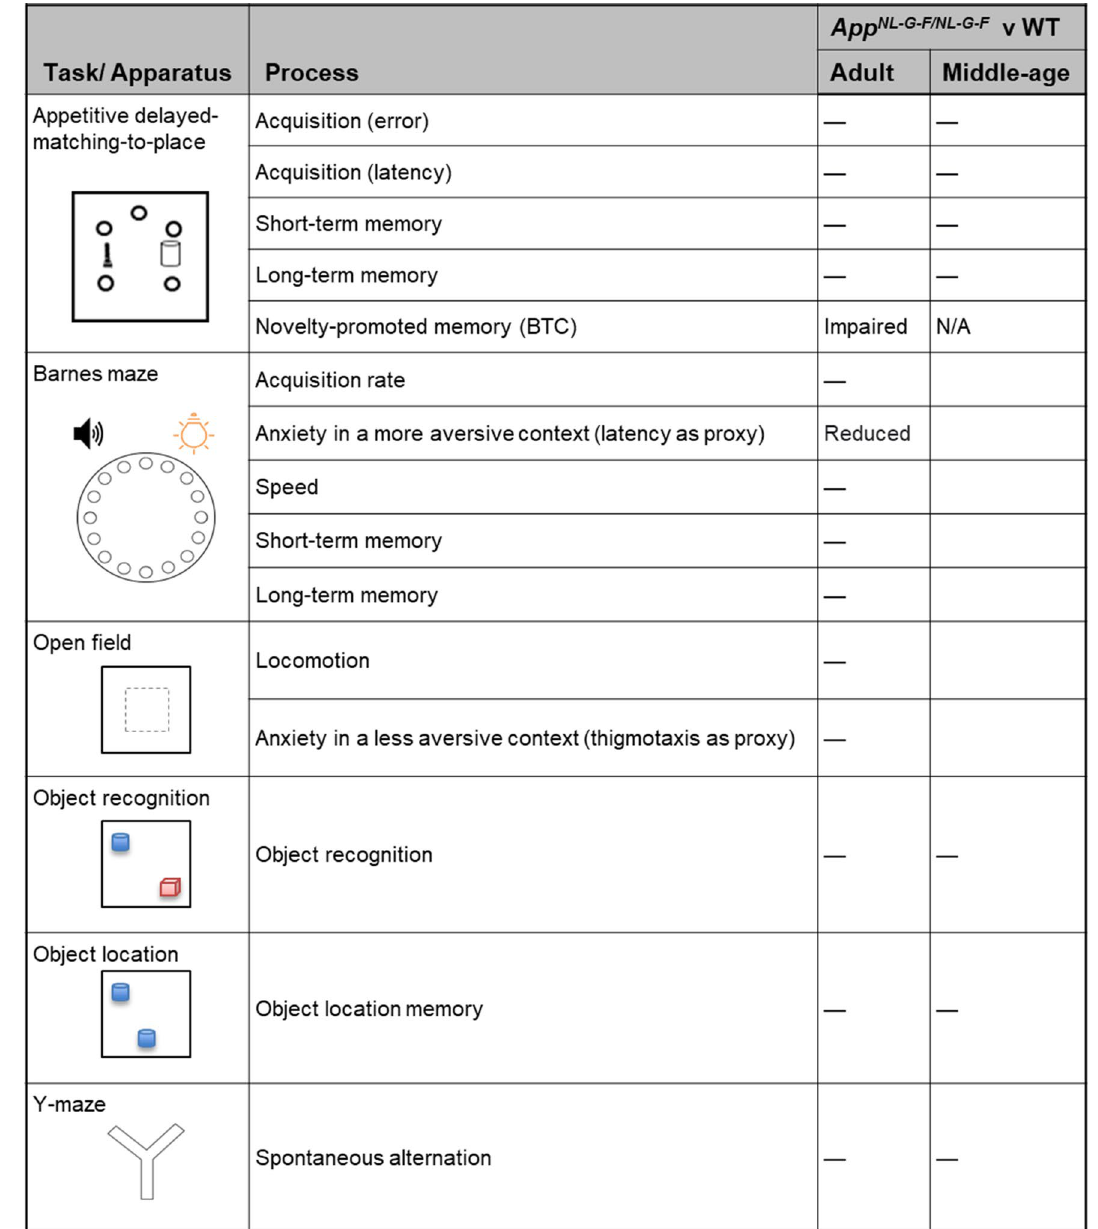
Table 1. Summary of the behavioural tasks and results of the App NL-G-F/NL-G-F compared to their WT littermates. BTC behavioural tagging and